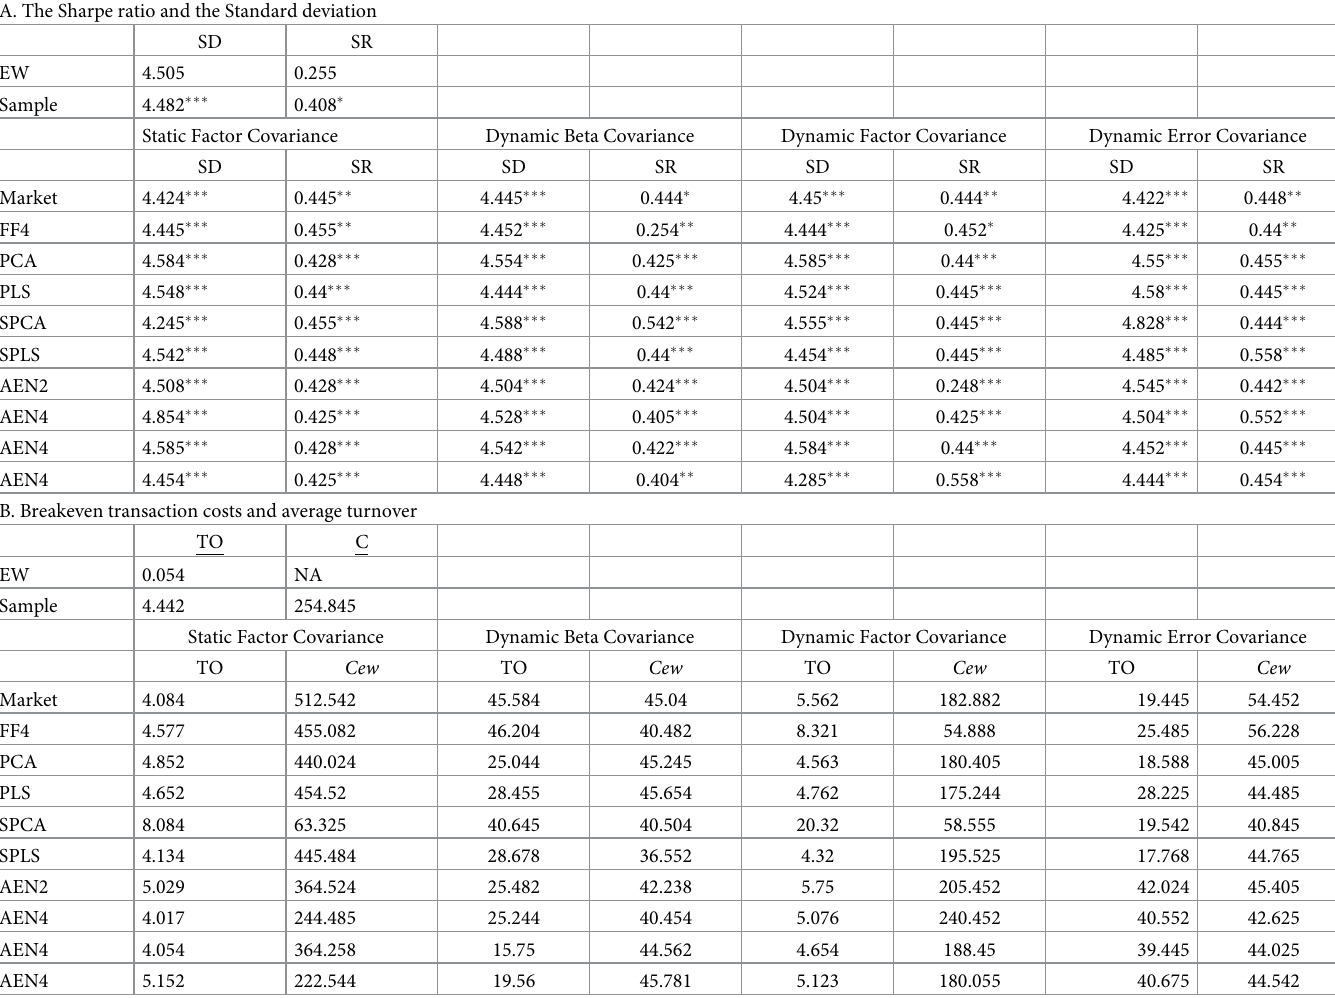
Table 7. Portfolio performance based on industry categorization for the 49 Fama and French